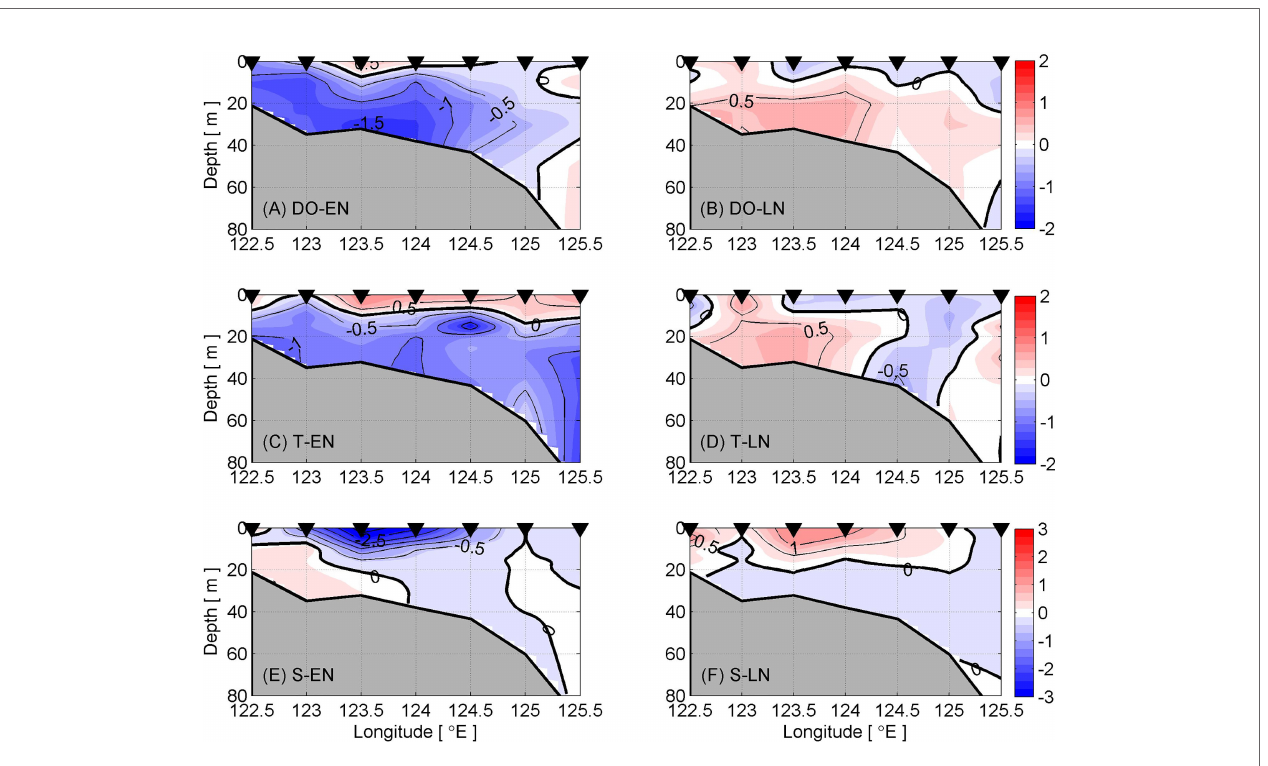
FIGURE 6 | Composite analysis of (A, B) DO, (C, D) temperature, and (E, F) salinity along Section C-C. Left and right panels indicate the El Niño and La Niña events, respectively. Triangles mark the sampling